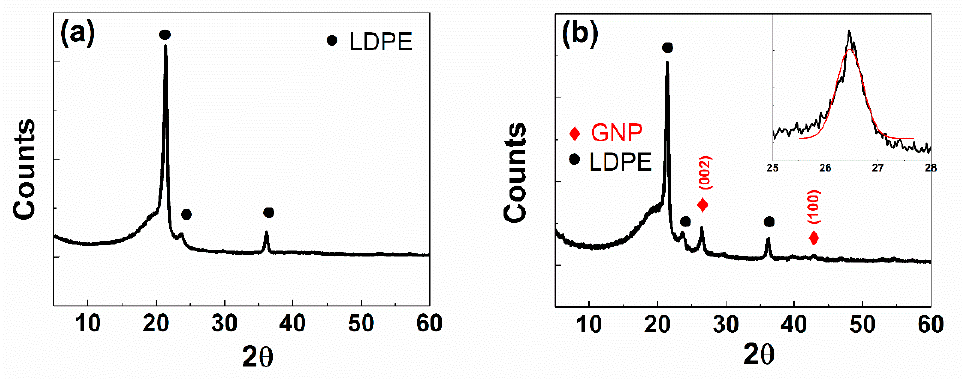
Figure 4. XRD diffractogram of pristine LDPE ( a ), and GNP on LDPE ( b ). The Gaussian fit of (002) peak in the inset of Figure ( b ).